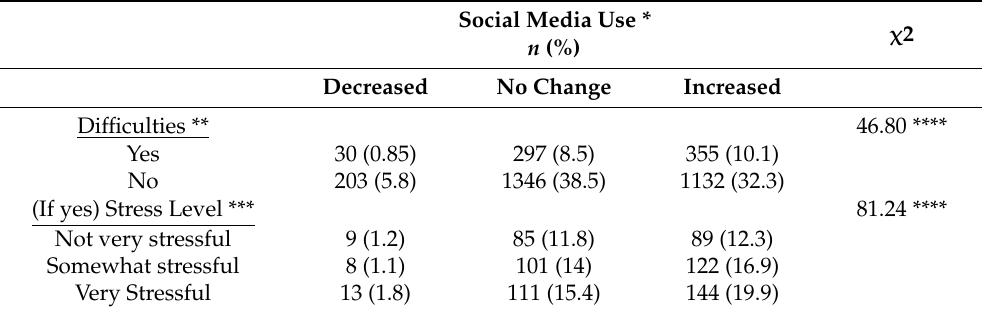
Table 7. Wave 2 Survey data: Social media use among individuals who did or did not have difficulty accessing important daily supplies during April 2021 ( n =